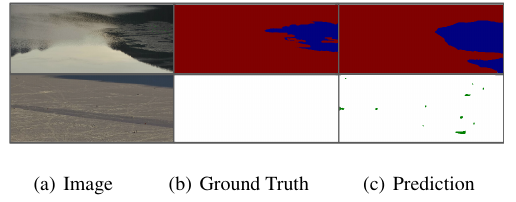
Figure 11: Cam1 results when the model is trained only on Cam0.